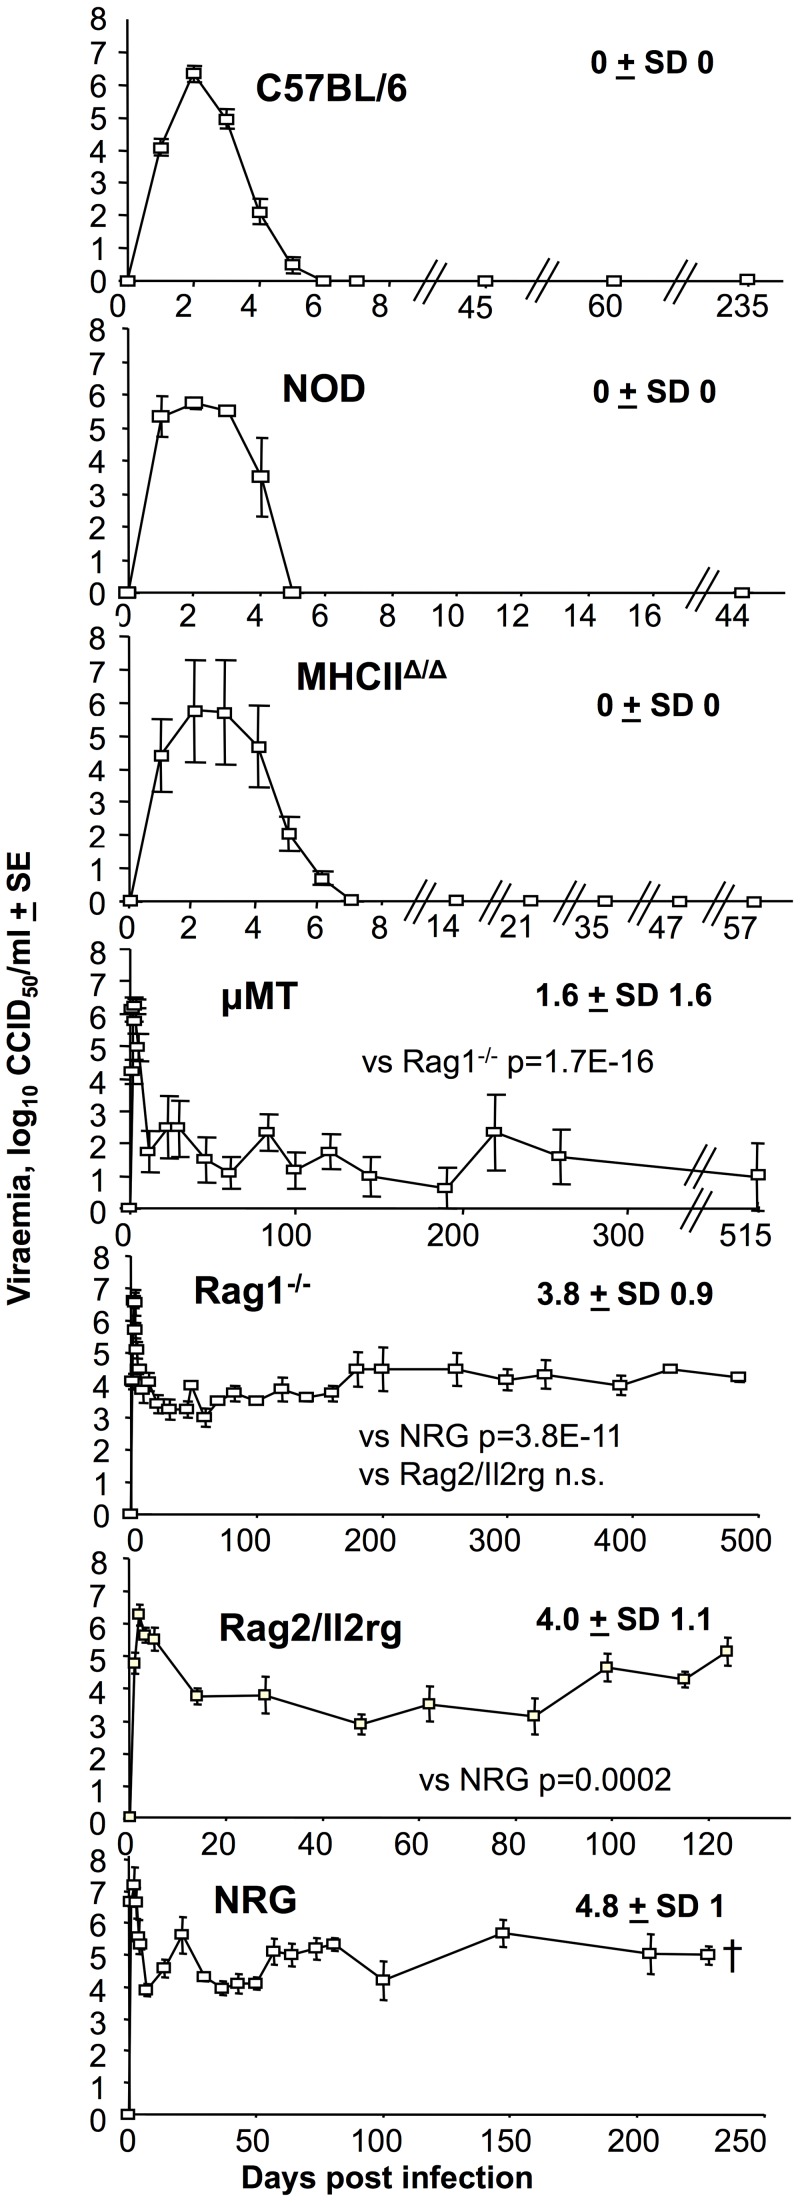
Viraemias in different mouse strains; B cell deficiency results in persistent “set point” viraemias.The viraemias for the indicated mouse strains at the indicated times are shown (strains ranked best to worst in terms of ability to control the viraemia); C57BL/6 (n = 43–50 mice before day 6, 3–9 thereafter; data from 8 independent experiments; not all time points were tested in each experiment), NOD (n = 6, except day 44 where n = 4, data from 2 independent experiments), MHCIIΔ/Δ (CD4 T cell deficient) (n = 9–16 day 0–6, n = 4–7 thereafter; data from 4 independent experiments), µMT (B cell deficient) (n = 6–10; data from 2 independent experiments), Rag1−/− (B and T cell deficient) (n = 7–16; data from 3 independent experiments), Rag2/Il2rg (B, T and NK cell deficient) (n = 4), NRG (B, T and NK cell deficient on a NOD background) (n = 5–13 day 0–37, n = 3–9 thereafter; data from 3 independent experiments). Set-point viraemia levels for each mouse strain are indicated (bold, top right) and represent the mean (log10CCID50/ml of serum +SD) of all viraemia measurements taken ≥10 days post infection. For B cell deficient mice (bottom 4 panels), statistical comparisons (by t test) of set-point viraemia levels (e.g. p = 3.8E–11 for comparison of Rag1−/− with NRG) used all viraemia measurements taken ≥10 days post infection. All mice were on a C57BL/6 background except the NOD and NRG mice.